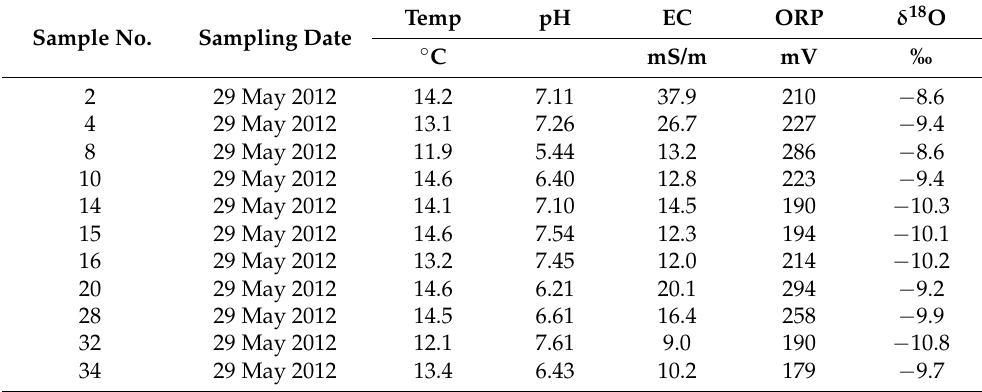
Table 4. Water temperature, pH, electric conductivity (EC), oxidation–reduction potential (ORP), and δ 18 O composition for groundwater samples in the Sho River alluvial fan on 29 May 2012.